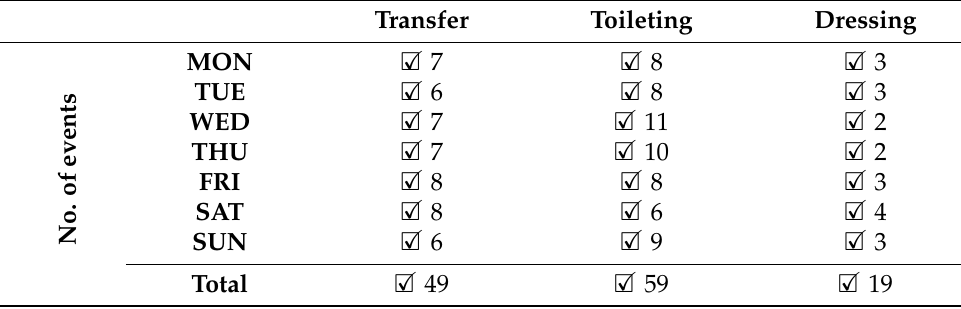
Table 17. Results of the first